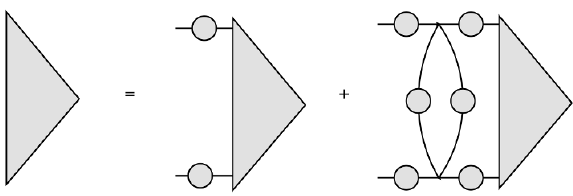
Figure 2. The Schwinger-Dyson equation for the exact three point function h ( x 1 ) O s ( x 3 ; (cid:15) 3 ) (cid:22) ( x 2 ) i